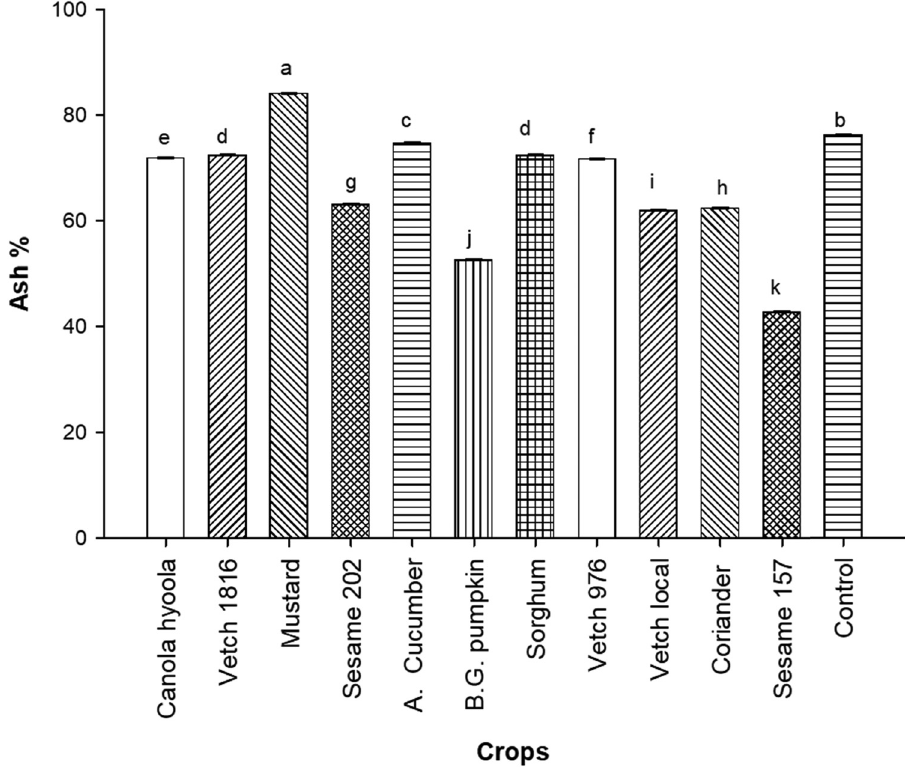
Figure 6: E ff ects of arti fi cial inoculation with Meloidogyne spp. and 11 trap crops on lettuce ash content by igniting in a mu ffl e furnace at 550°C for 8 h. The standard deviation of the means is designated by the error bar for each mean. Means followed by the same letter are not signi fi cantly di ff erent ( SNK, P > 0.05 ) .